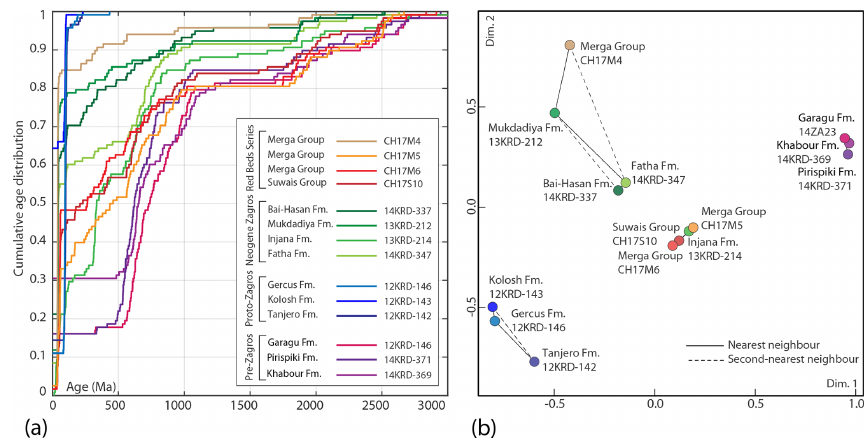
Figure 10. Comparison plots of the pre-Zagros orogeny, proto-Zagros foreland basin, Neogene Zagros foreland basin, and Red Beds Series deposits in the present-day Zagros hinterland: (a) detrital zircon U–Pb cumulative age distribution (Saylor and Sundell, 2016), and (b) two- dimensional multidimensional scaling plot depicting relative statistical similarity/dissimilarity based on the Kolmogorov–Smirnov test D value (Vermeesch, 2013) of the detrital zircon U–Pb ages for the same sample sets as in the cumulative age distribution plot. Dimension 1 and 2 are